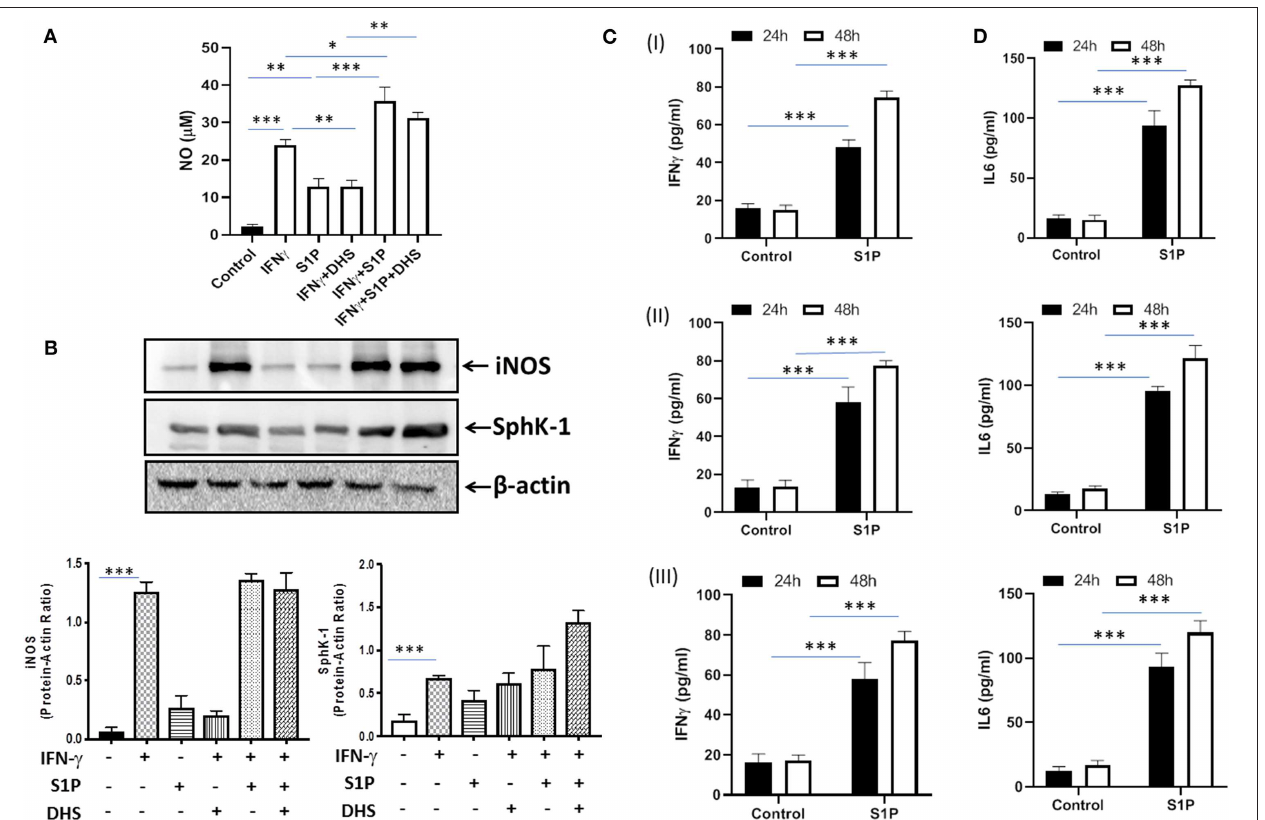
FIGURE 1 | Sphingosine-1-phosphate (S-1P) skews M1 effector response in macrophages. (A) RAW264.7 macrophages were stimulated as indicated, and NO titers were quantified from their culture supernatants. Shown here is the µ M of NO ± SEM from three independent experiments. (B) Whole cell lysates of macrophages used above were collected 24h post-treatment culture and analyzed for the expression of iNOS (M1 effector protein) and Sphk-1 proteins by immune blotting. A representative blot from several repeats with similar outcome is shown. β -actin was used as a loading control. Mean density of each protein was quantified from various blots by ImageJ software, and the values were plotted in terms of relative protein expression. (C) RAW macrophages (I) , CD11b + peritoneal (II) , and bone marrow–derived macrophages (III) were treated with S-1P for indicated time intervals. Cell culture supernatants were collected, and IFN- γ (C) and IL-6 (D) were measured by ELISA at 24 and 48h, respectively. Shown here is the pg/ml of cytokines released during the course of infection ± SEM from three independent experiments. Statistical analyses were conducted using two-way ANOVA followed by Bonferroni posttest (* P < 0.05, ** P < 0.01, *** P <